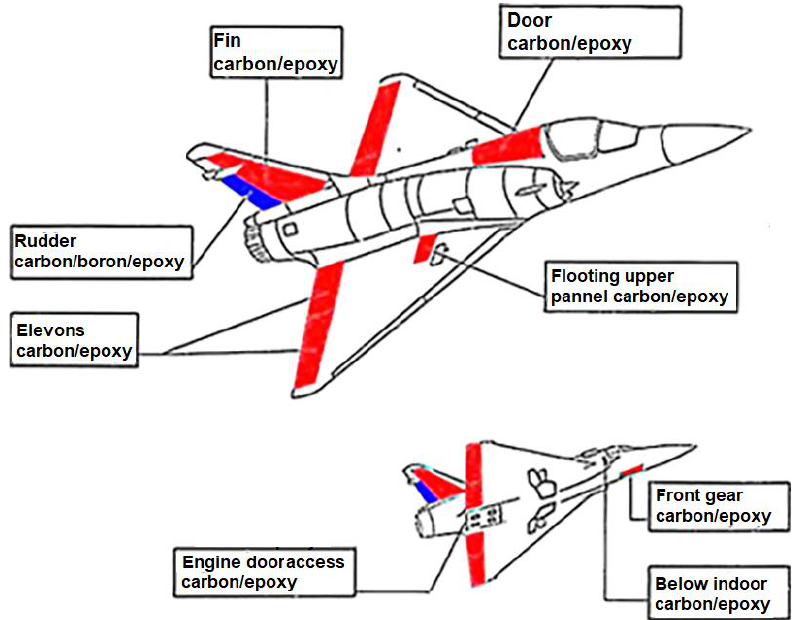
Figure 17. Dassault Mirage F1 with carbon and boron sandwich structure [151]. Reproduced with permission from Elsevier.